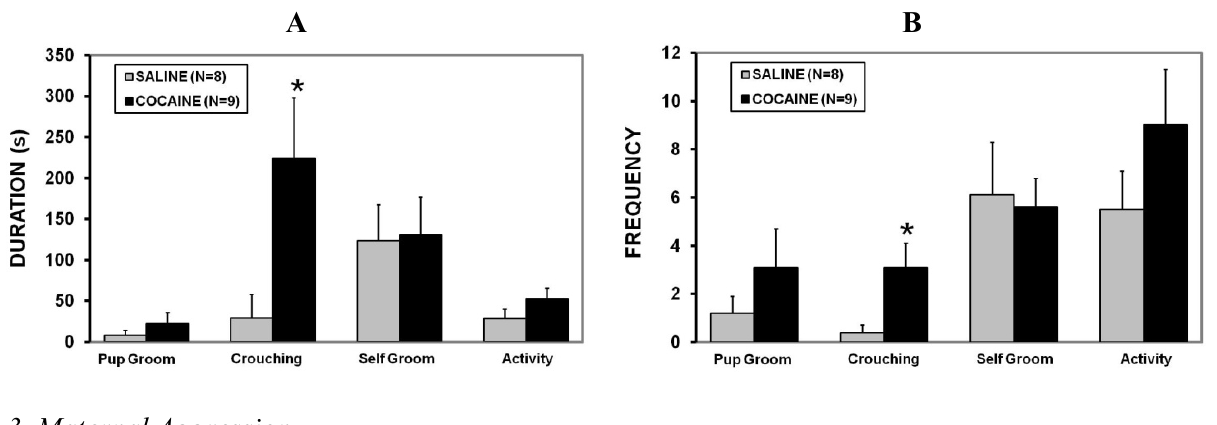
Figure 3. Mean ± SEM seconds (s) duration ( A ) and frequency ( B ) for four behaviors during a 15 min maternal care test on the 8th day of pup exposure in nulliparous rats previously treated with 10 consecutive days of saline or 15 mg/kg cocaine as adults. Samples sizes listed in parentheses. * Indicates a significant difference between saline and cocaine for an individual behavior ( p <